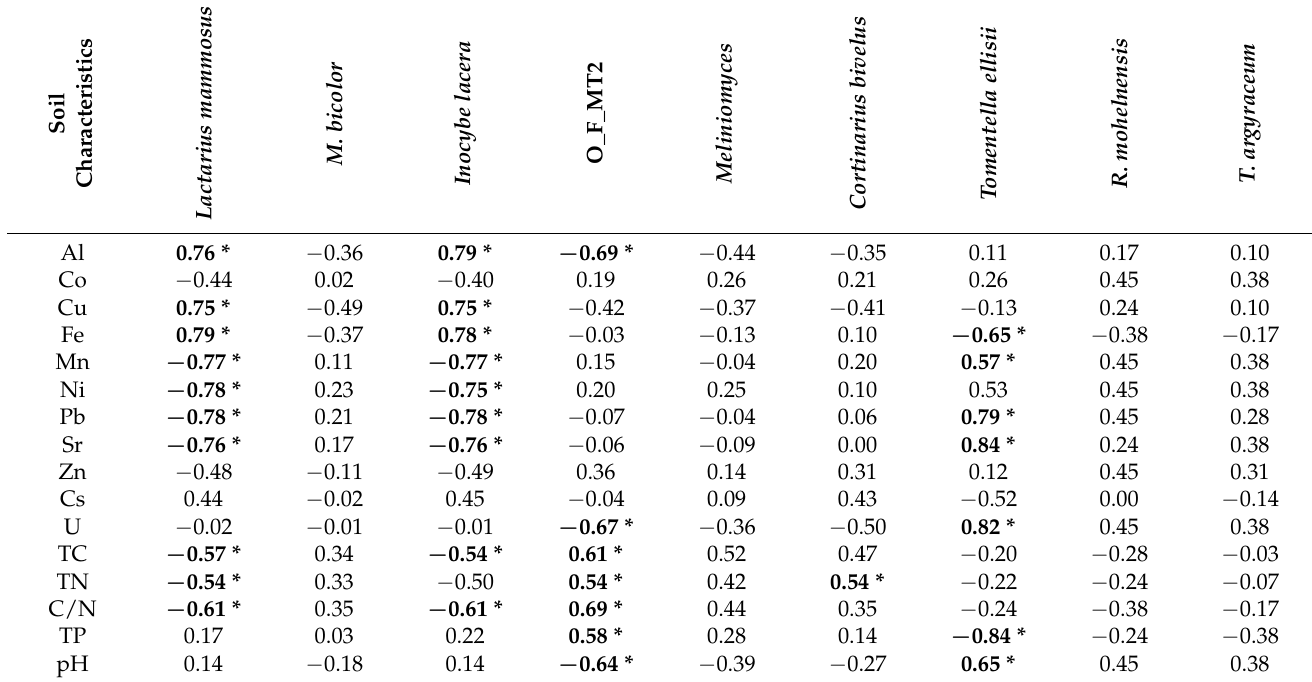
Table 5. Coefficients of correlation between soil characteristics and ectomycorrhizal morphotypes and ECM fungi described for the field plants.